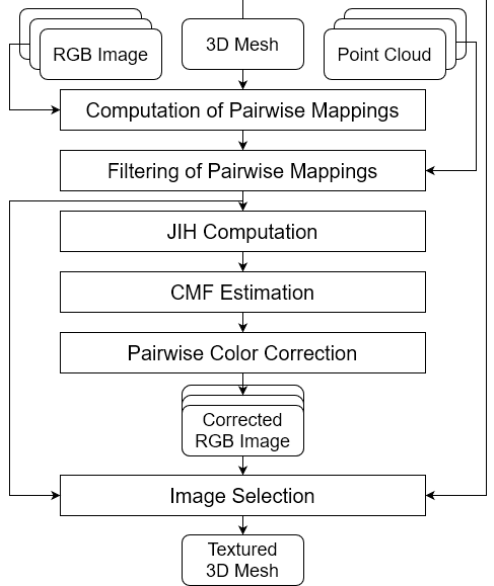
Figure 1. Architecture of the proposed approach. As input, our system receives RGB images, a 3D mesh and registered point clouds from different scans. Firstly, the faces present in the 3D mesh are projected onto the images to create the pairwise mappings. Then, the pairwise mappings are filtered using several filtering techniques. The filtered pairwise mappings are then used to compute a JIH for each pair of images. Subsequently, each JIH is used to estimate a CMF. To produce the corrected RGB images, a pairwise color correction procedure is carried out using the CMFs. At the end, we compute a textured 3D mesh using an image selection technique that receives the corrected RGB images, the 3D mesh and the filtered pairwise